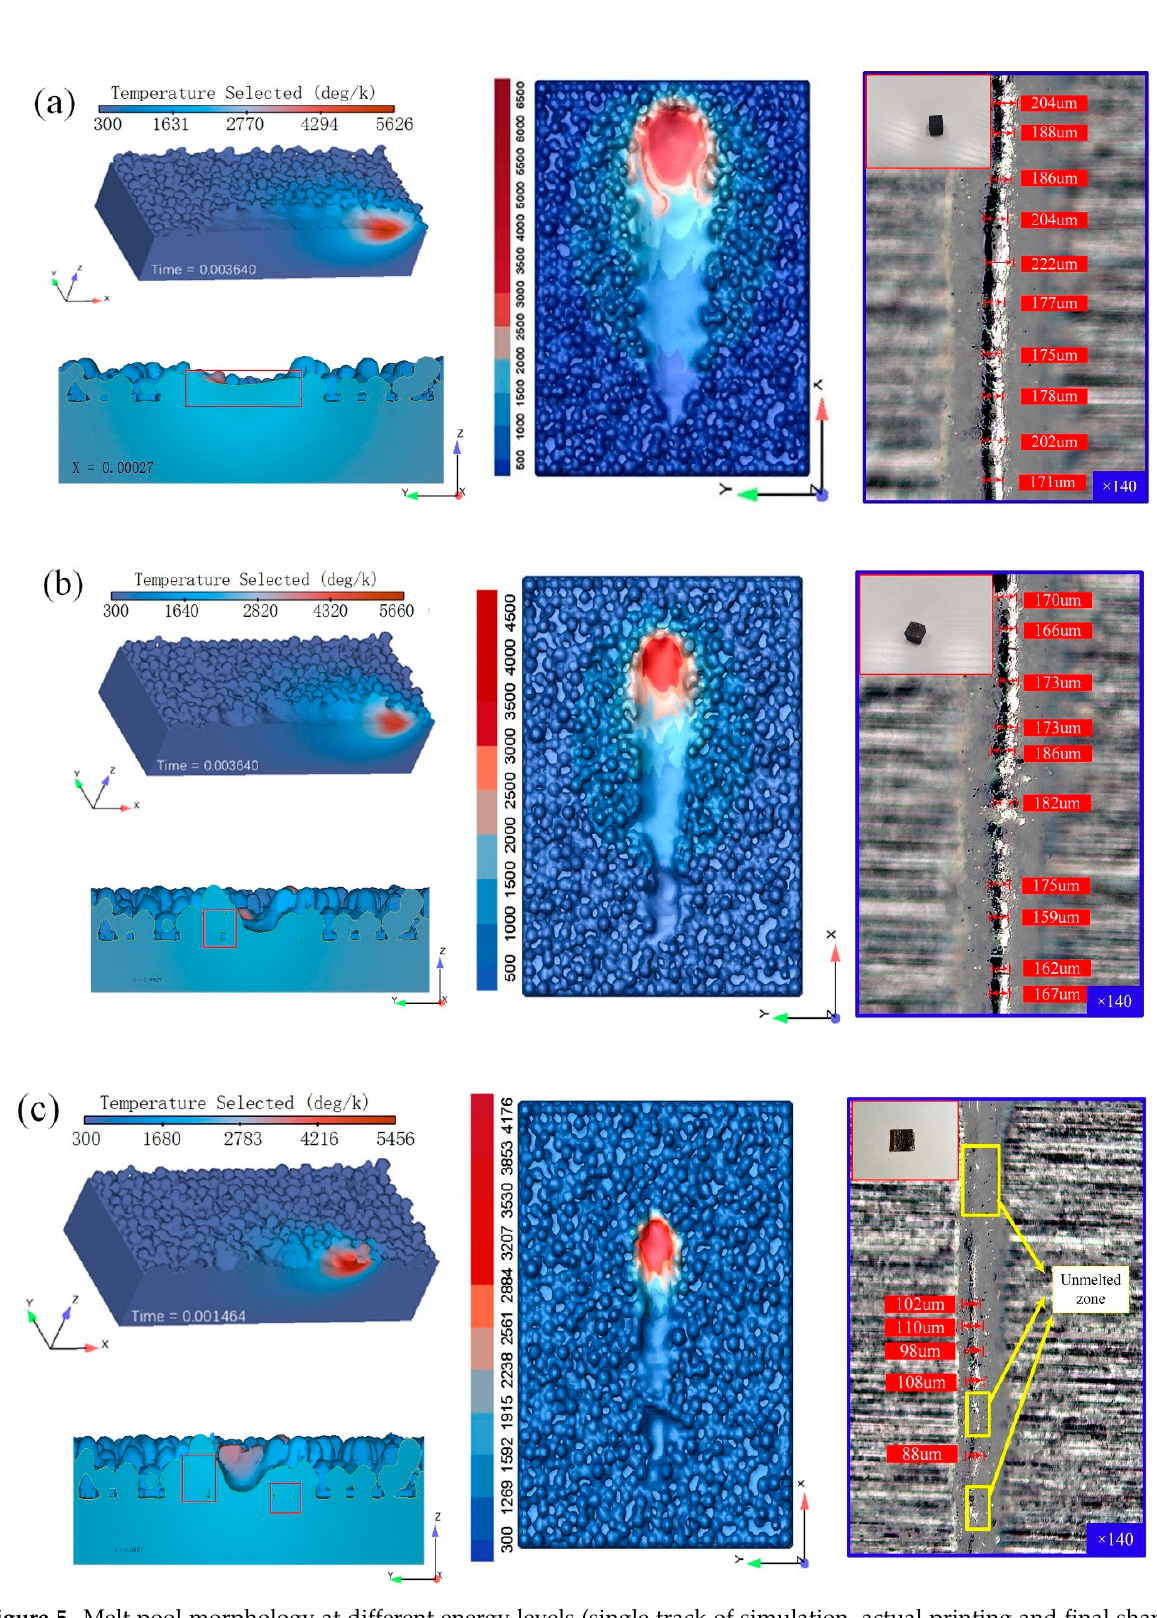
Figure 5. Melt pool morphology at different energy levels (single track of simulation, actual printing and final shape). ( a ) 4.0 × 10 11 J/m 3 , P = 400 W, V = 400 mm/s; ( b ) 3.1 × 10 11 J/m 3 , P = 310 W, V = 400 mm/s; ( c ) 1.6 × 10 11 J/m 3 , P = 400 W, V = 1000 mm/s.